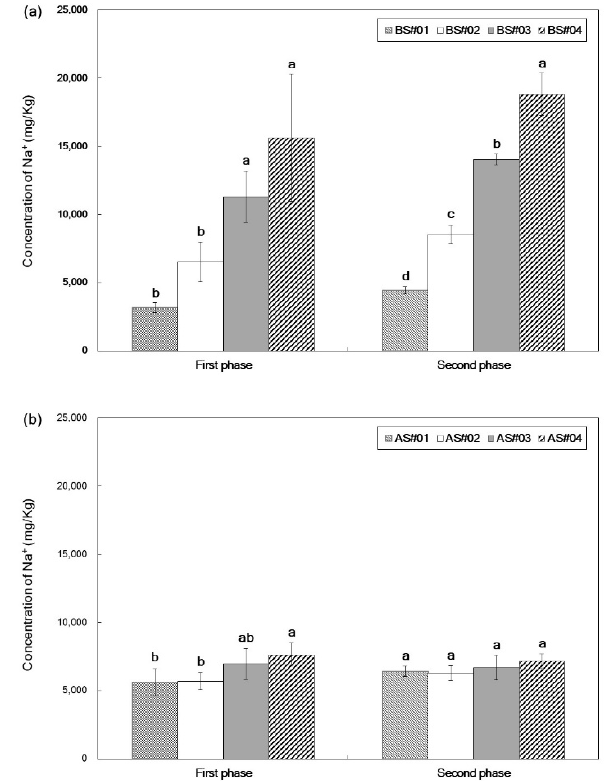
Figure 7. Effect of ( a ) saline and ( b ) desalinated irrigation water on Na+ concentration in the leaves. Bars represent the mean ± standard deviation, n = 5. Different letters indicate significant differences among treatments by Tukey’s honest significant difference test at p < 0.05. BS: before water treatment using the BWD system, i.e., saline water irrigation; AS: after water treatment using the BWD system, i.e., desalinated water irrigation.